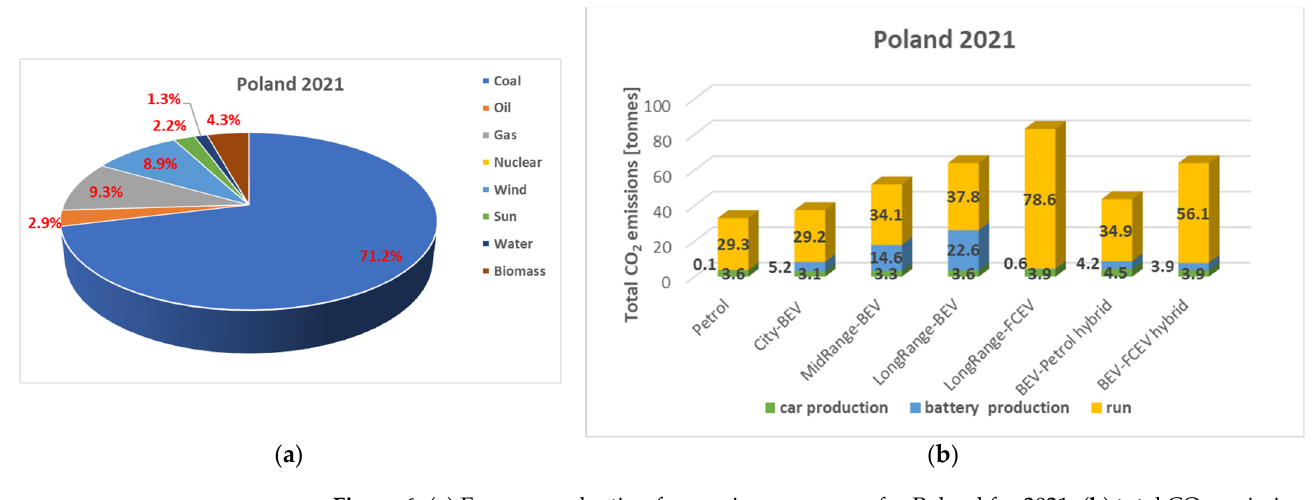
Figure 5. ( a ) Energy production from primary sources for Germany for 2021 ( b ) total CO 2 emissions for 2021 for Germany for different types of cars, including car and battery production, as well as running of the vehicle considering different sources for energy production .